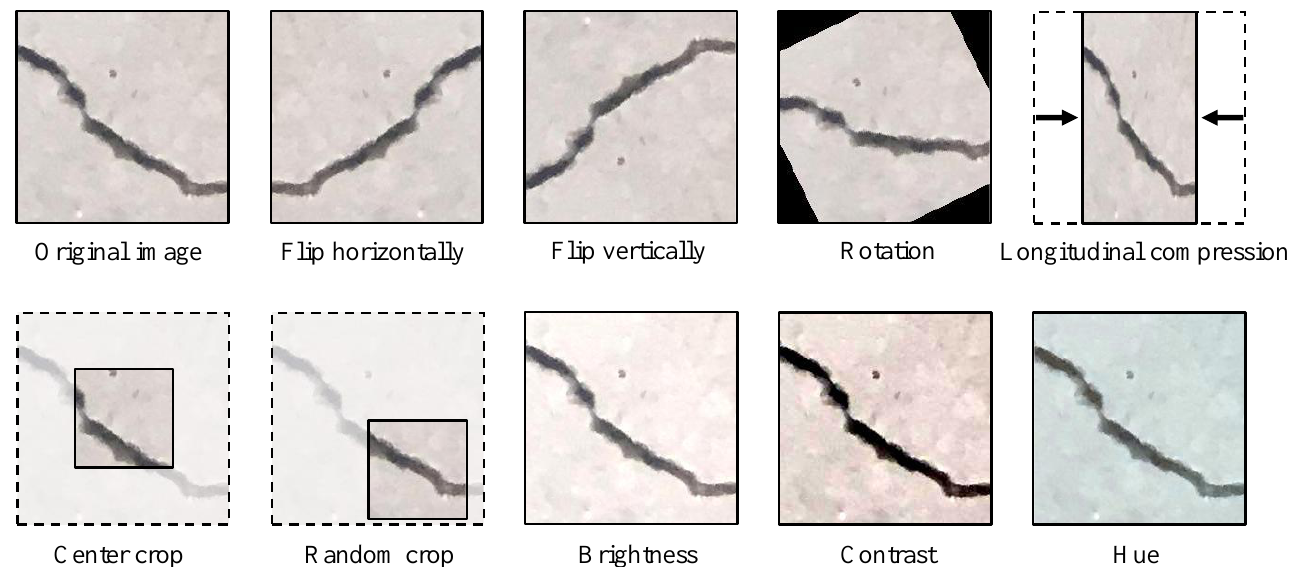
Figure 4. Comparative illustrations before and after data